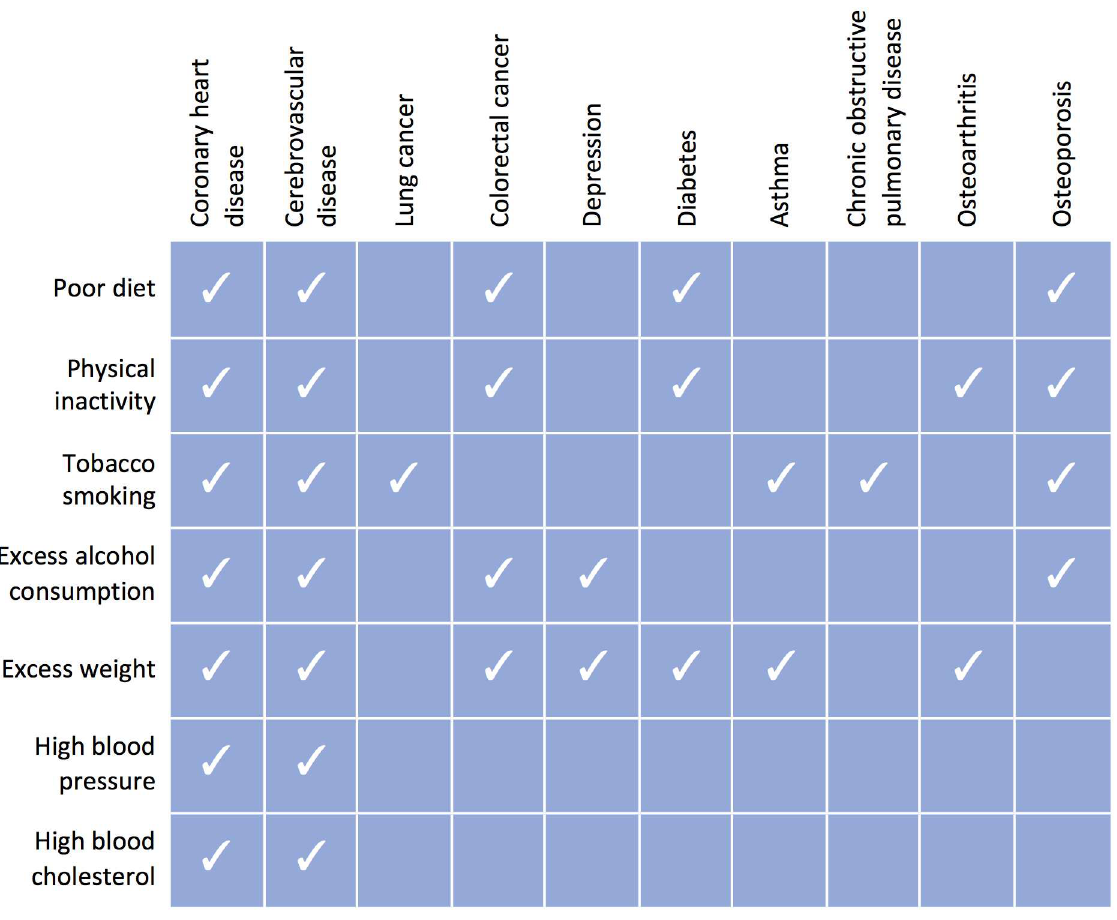
Fig 1. The contributions of modifiable risk to common chronic diseases. Source: Institute of Health and Welfare 2002. Chronicdiseasesand associated risk factors in Australia, 2001. Canberra:AIHW.